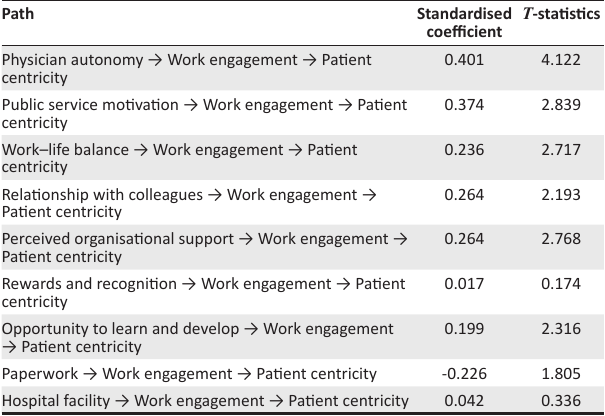
TABLE 4: Specific indirect